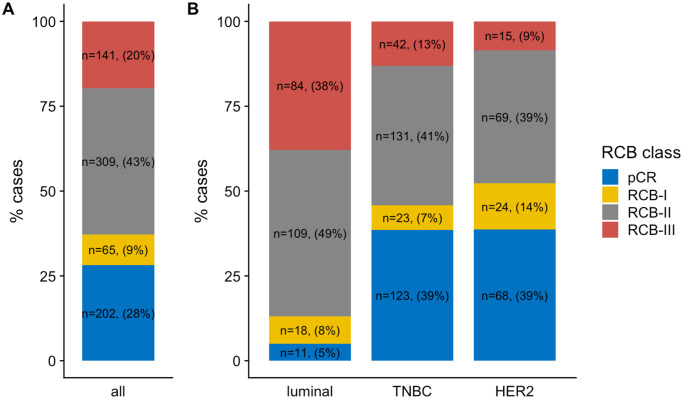
RCB class distribution among the whole population and by BC subtypes: A) among the whole population, B) in each subtype population.